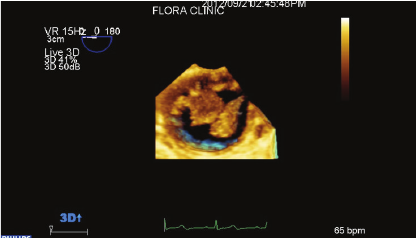
Figure 3: Three-dimensional transesophageal echocardiogram (3D TEE) demonstrating two thrombi in cross-section.